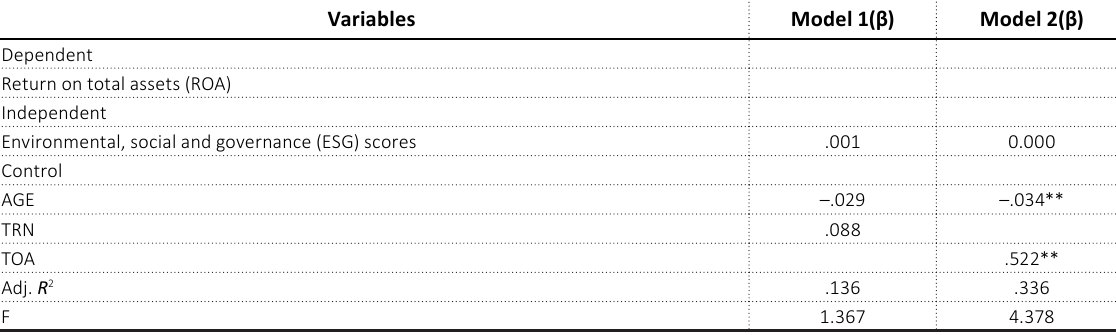
Table 6. Results of regression analysis for ESG as an independent variable